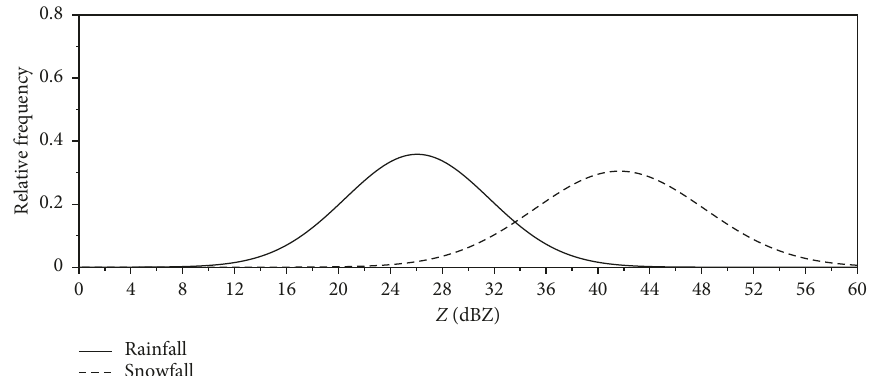
Figure 6: Comparison of probability density functions for rainfall and snowfall data over the elevation zone of 250 ∼